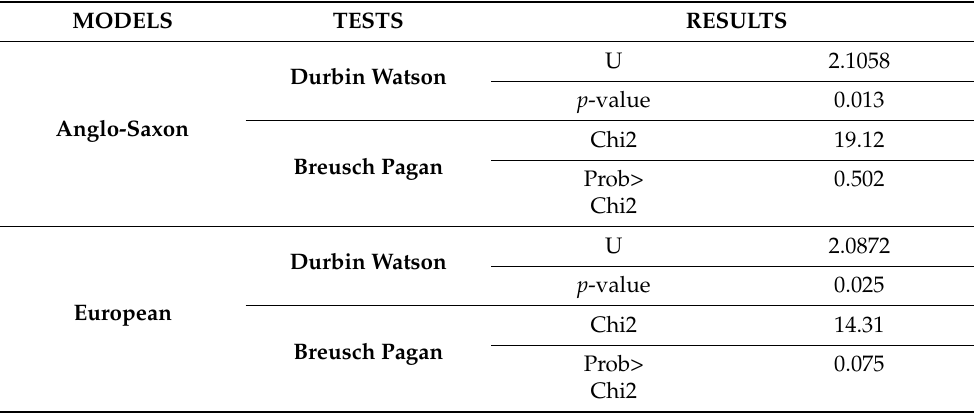
Table 5. Breusch-Pagan and Durbin-Watson tests